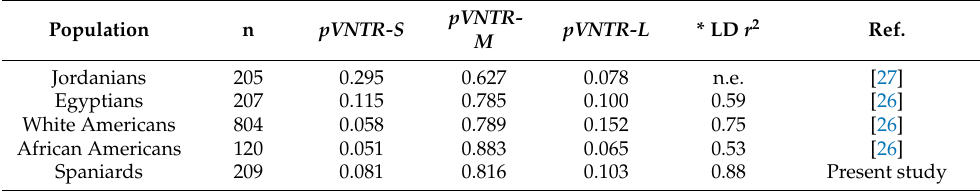
Table 2. Minor allele frequency of CYP2C9 pVNTR alleles in different